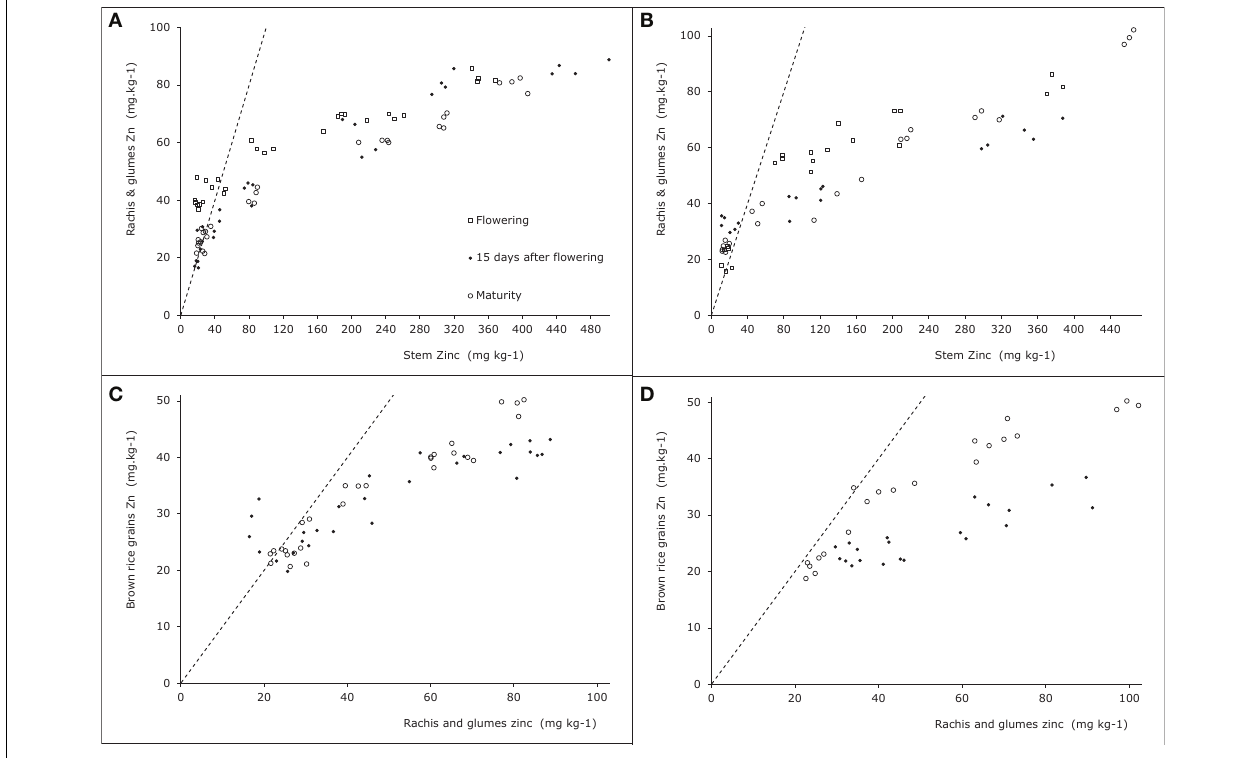
represent individual replications. The open squares, black dots, and open circles represent plants during flowering, mid grain filling, and grain maturity respectively, the broken lines indicate the 1:1 line in each panel.